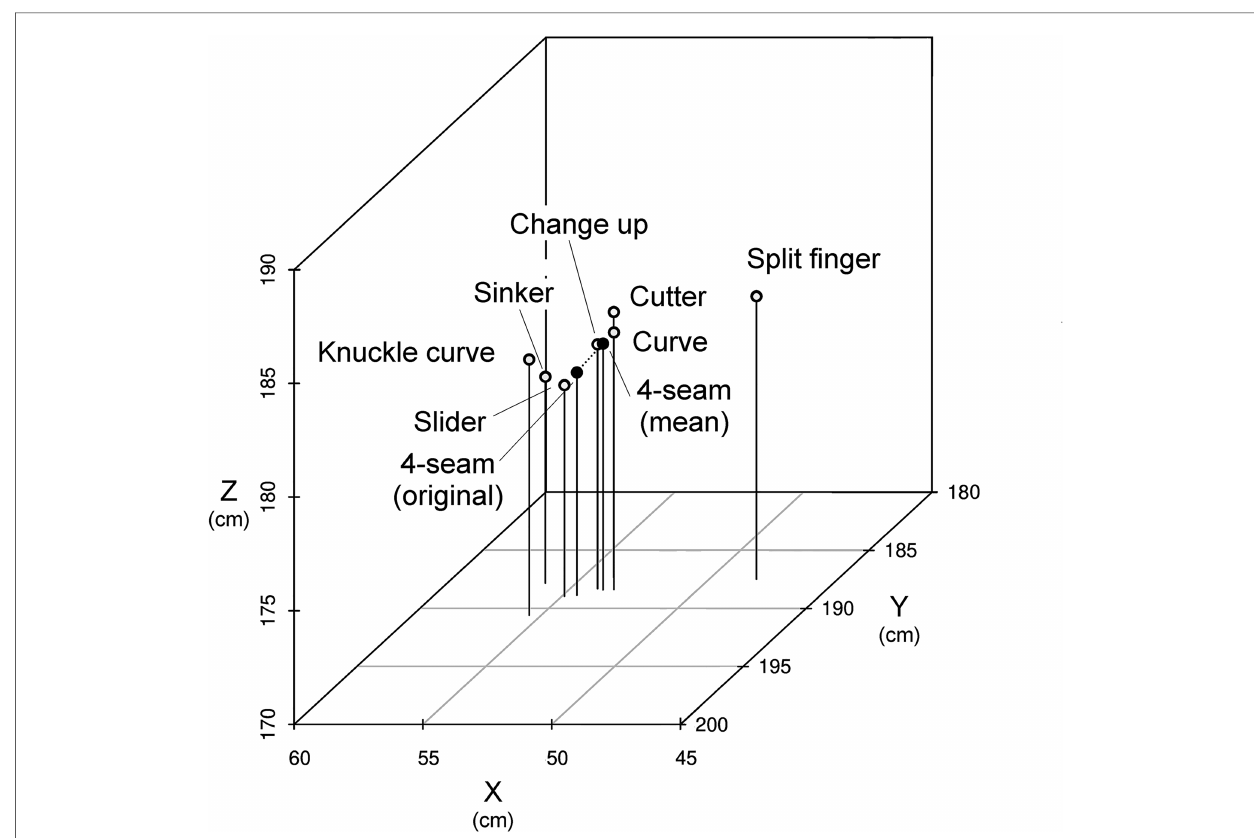
FIGURE 1 Difference in release point of 4-seam according to ball type. Data in the white circle with the name of each ball type indicate the 4-seam data of the pitcher who threw each ball type. 4-seam (original) shows the average data of pitchers ( n =1363) who threw more than 50 4-seam balls a year between 2015 and 2021, excluding 2020. 4-seam mean demonstrates the average value of the 3D coordinates (X, Y, and Z axes) for each ball type (data in seven white